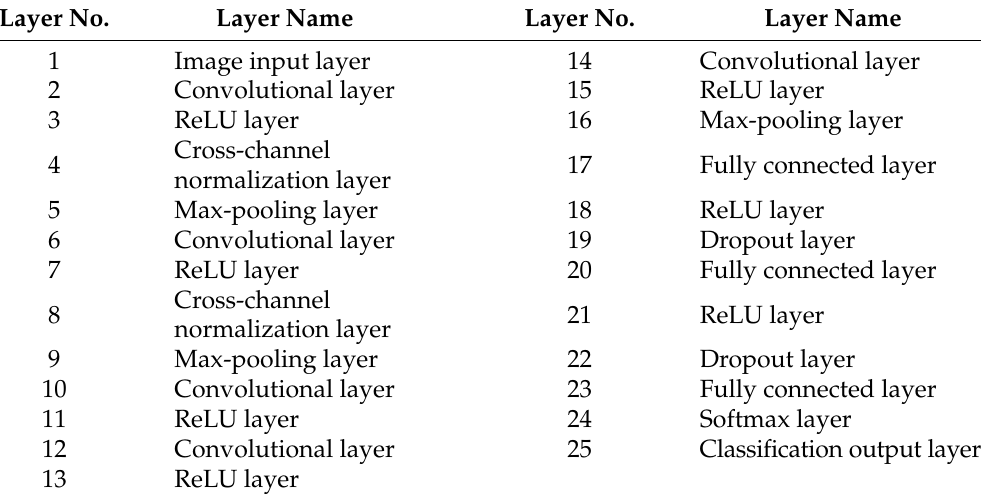
Table 1. Architecture of AlexNet deep learning classification network. Layer